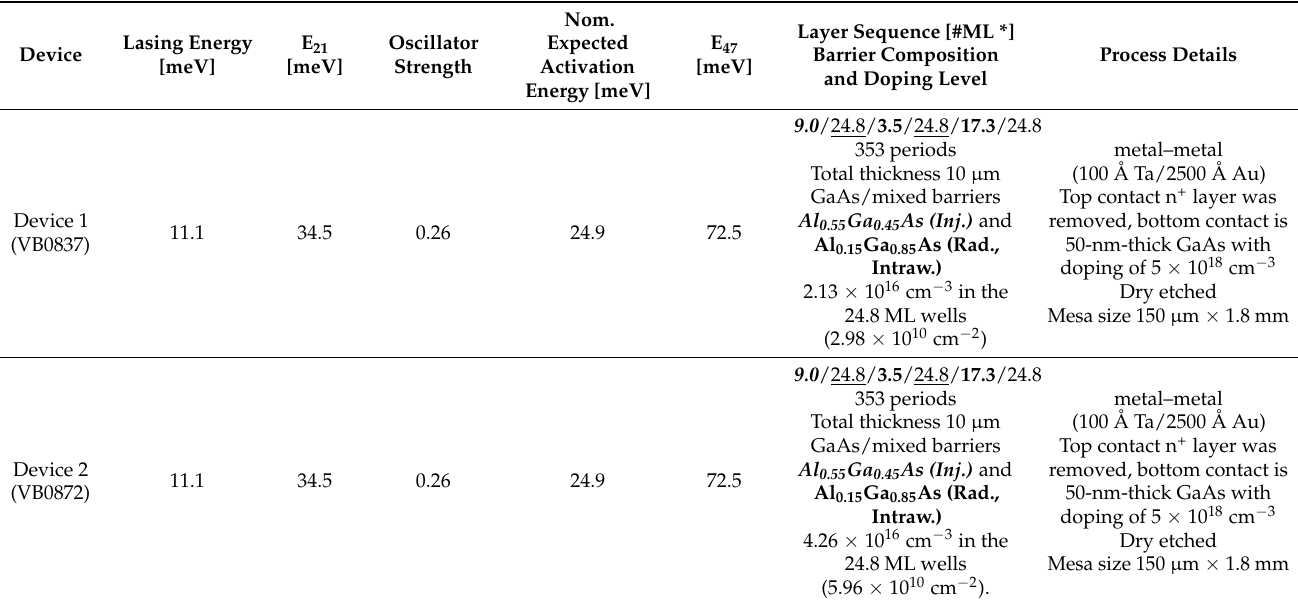
Table 1. Main nominal design parameters and device data.